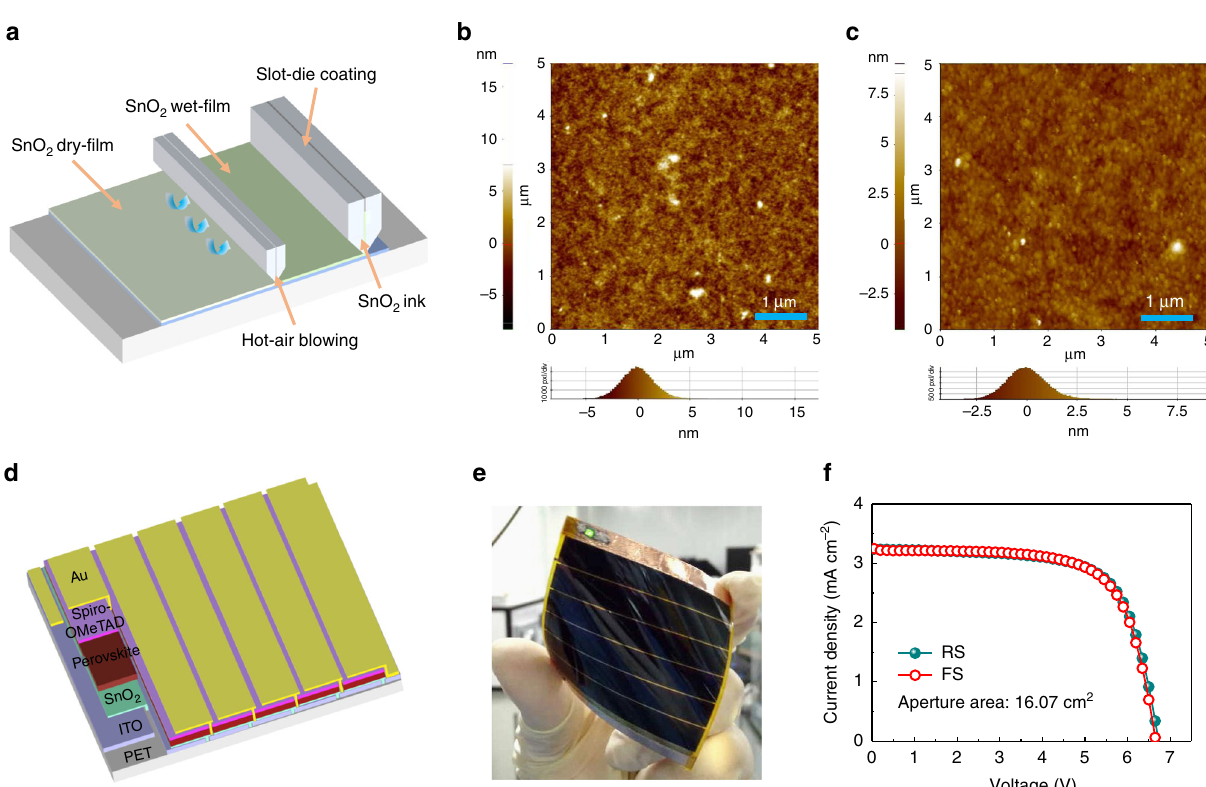
Fig. 1 Performance of large-area fl exible PSCMs based on slot-die-coated SnO 2 substrates. a The schematic of slot-die coating of SnO 2 fi lms. b AFM images of the as formed SnO 2 fi lms without hot air assistance and c with hot air blowing. d The structure of the 6 sections series connected large-area fl exible PSCMs. e A photograph of the fl exible PSCM and f the corresponding J-V curves of the champion fl exible (Supplementary Fig. 1e). The main loss of the device performance